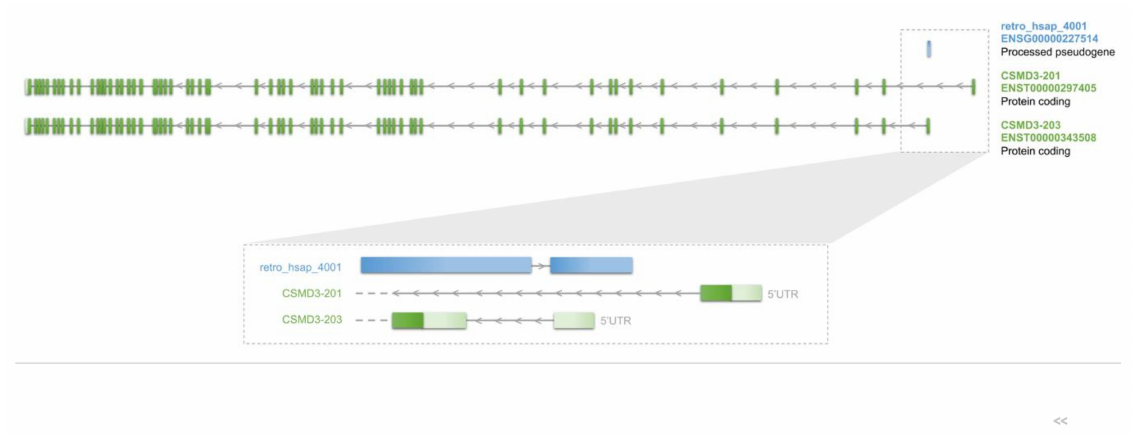
Figure 5. Example of retro_hsap_4001 contribution to novel isoforms of CSMD3